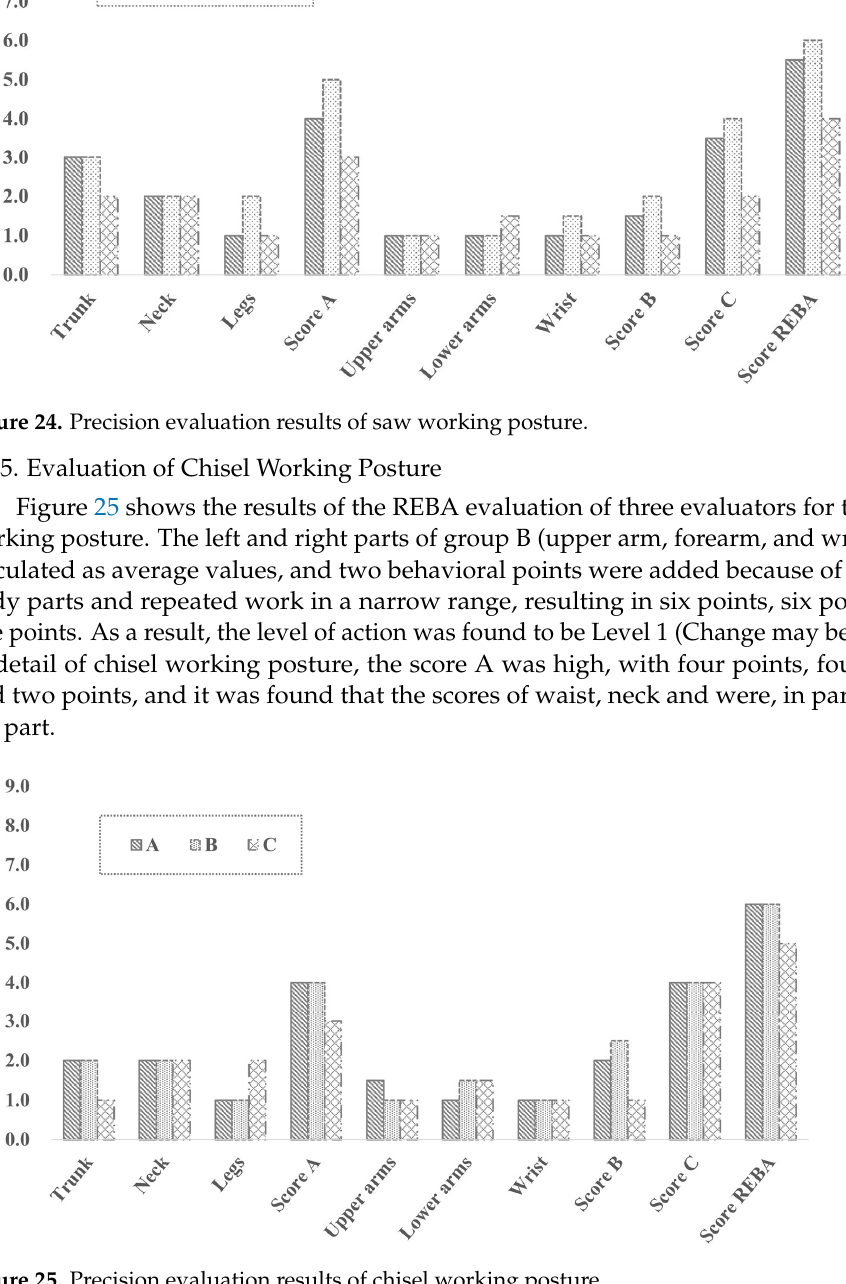
Figure 23. Precision evaluation results of drilling machine working posture.